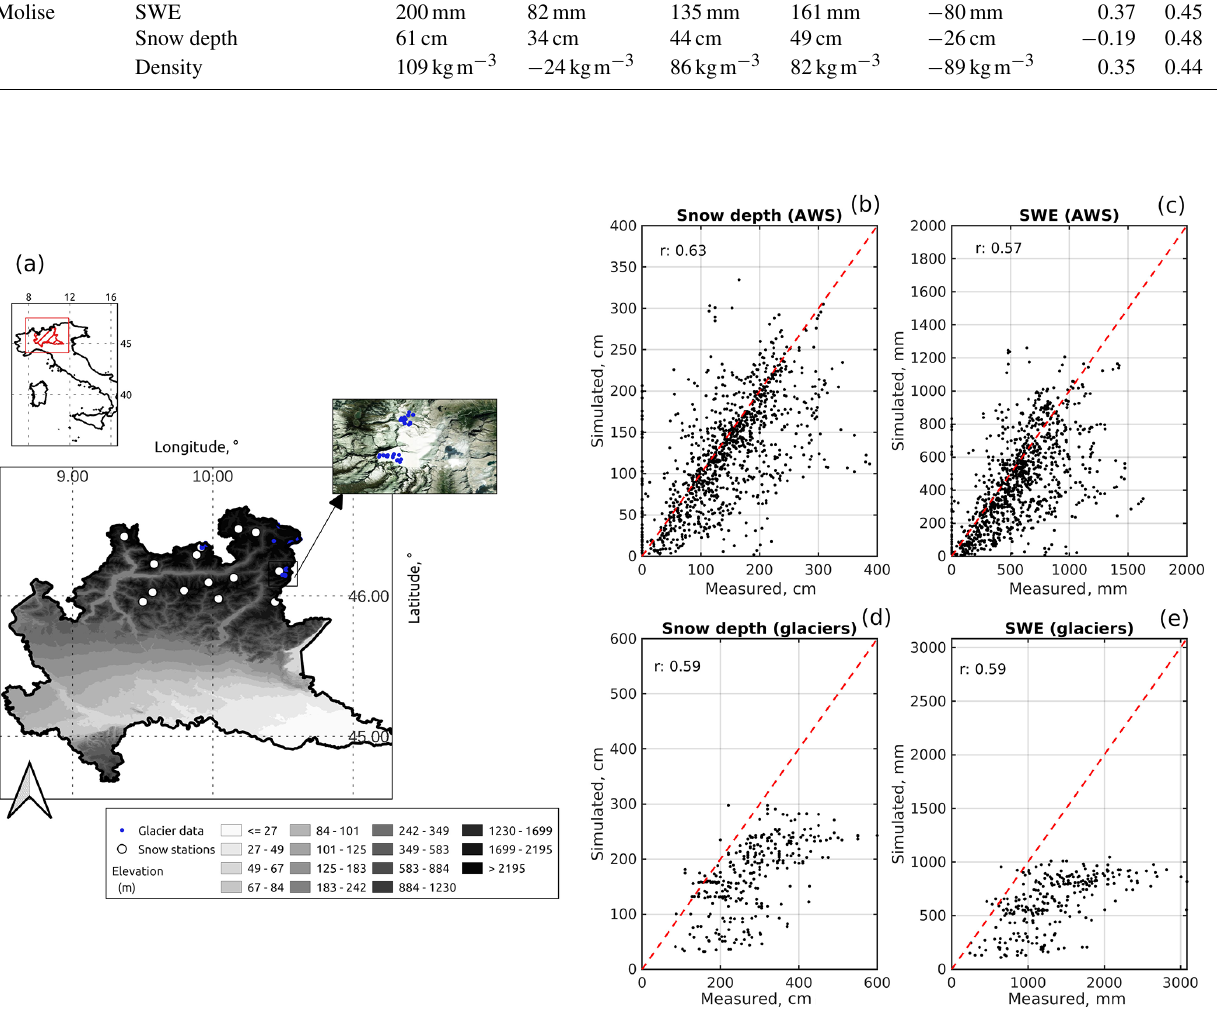
Figure 7. Evaluation of IT-SNOW in Lombardy. (a) Topography of the focus region, along with location of evaluation data and an example of glacier data sampling geometry (b, c) IT-SNOW vs. SNOWPACK snow depth and SWE at medium-elevation snow stations, respectively. (d, e) Observed vs. IT-SNOW snow depth and SWE at very-high-elevation glacier sites in the context of end-of-season mass balance surveys. r is Pearson’s correlation coefficient, AWS is automatic weather station, and SWE is snow water